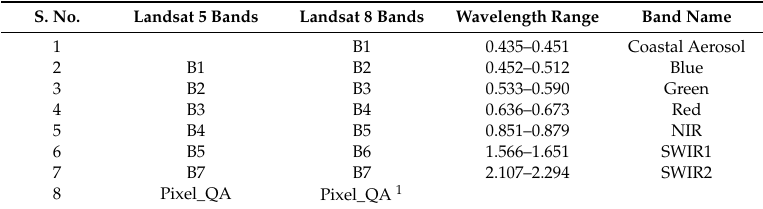
Table 1. The bands, ranges and names of Landsat 5 and Landsat 8 data.